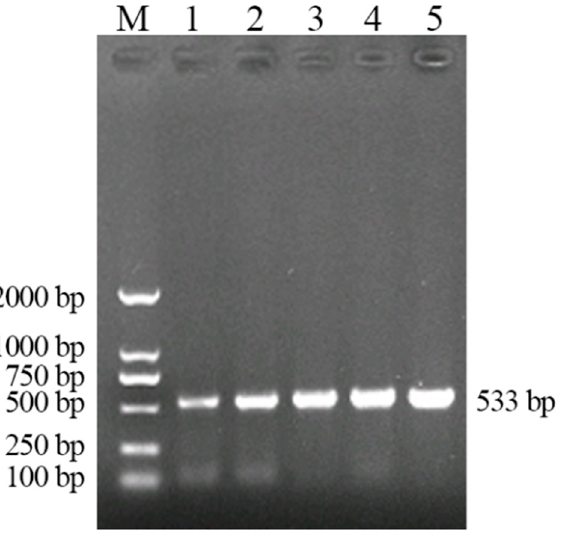
Figure 3. Optimization of the annealing temperature for the primer AP1-2/AP3-1. M: DL 2000 DNA marker; 1–6: annealing temperatures of 58, 59, 60, 61 and 62 °C, respectively. marker; 1–6: annealing temperatures of 58, 59, 60, 61 and 62 ◦ C,